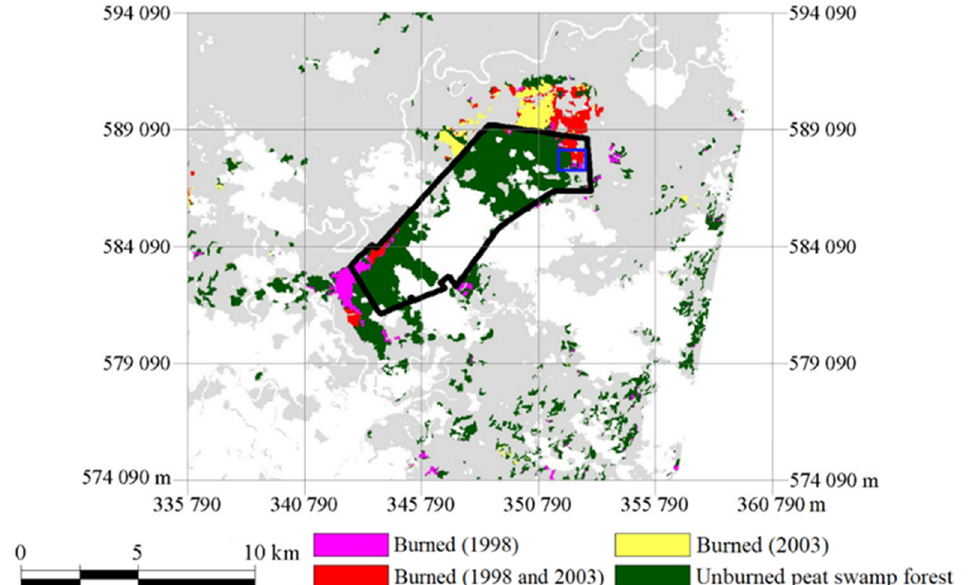
Figure 3. Fire frequency map of Klias Forest Reserve (Black polygon) derived from high-resolution satellite images. Rectangle in blue is the study site. Grey and white colors represent other land cover and cloud/ shadow, respectively. Table 2. Land cover statistics of patches of different fire frequencies.